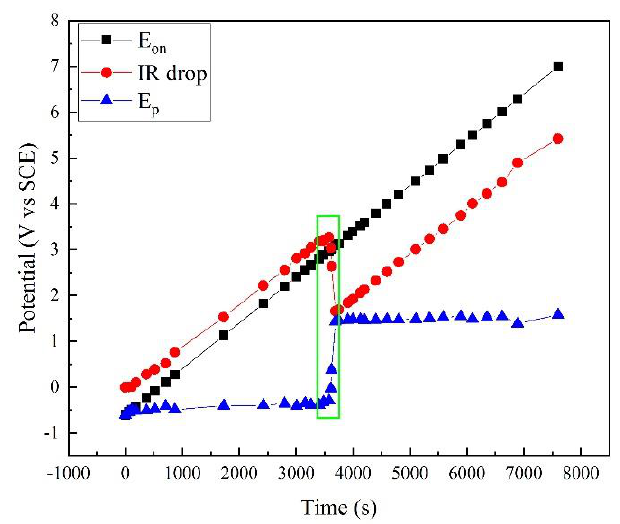
Figure 3. Comparison of E on , E p , and IR drop in polarization measurement of X80 steel in 4 g · L − 1 Na 2 SO 4 solution.